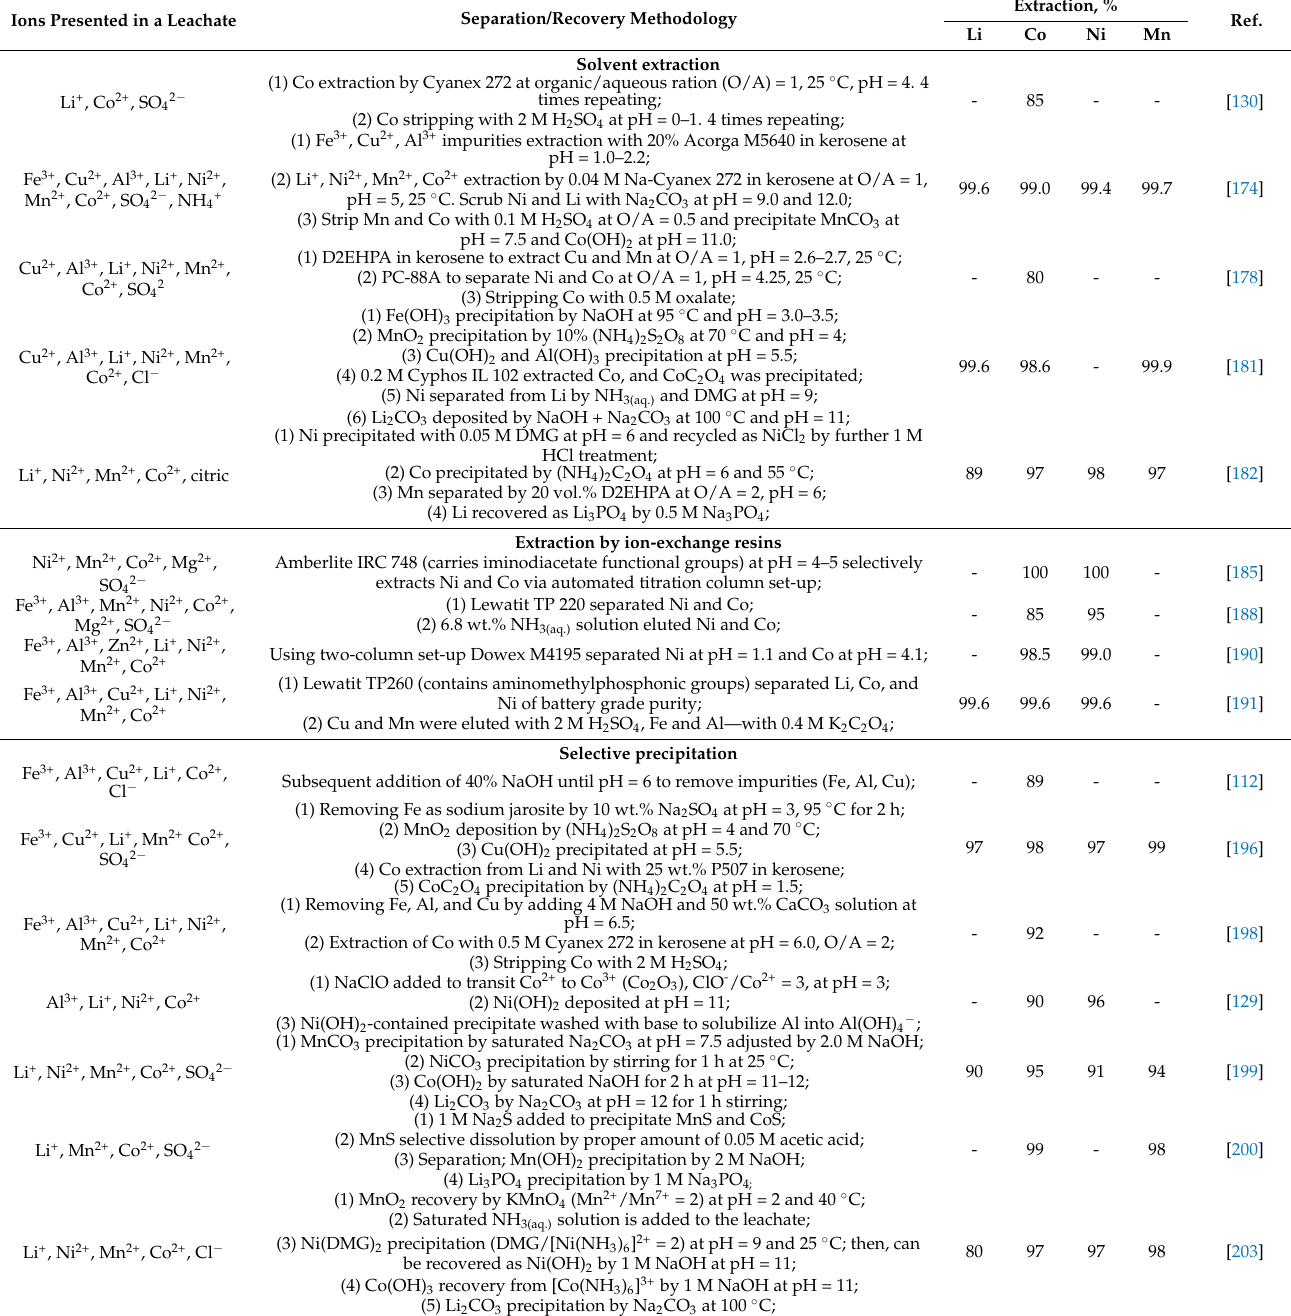
Table 2. Approaches of valuable metals separation and